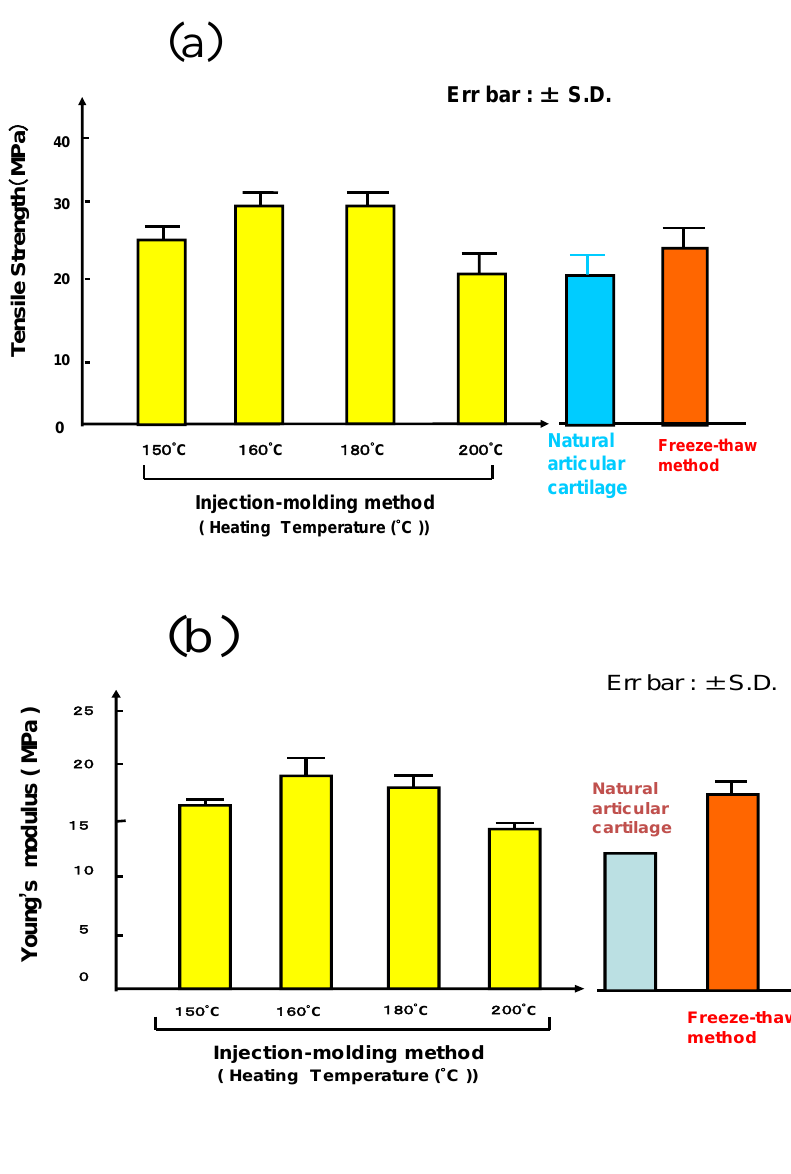
Figure 3. The mechanical properties of PVA-Hs by two fabrication methods (degree of polymerization: 8,800, Water content: 30%): (a) Influence of heating temperature on Young’s modulus (MPa). (b) Influence of heating temperature on ultimate tensile strength